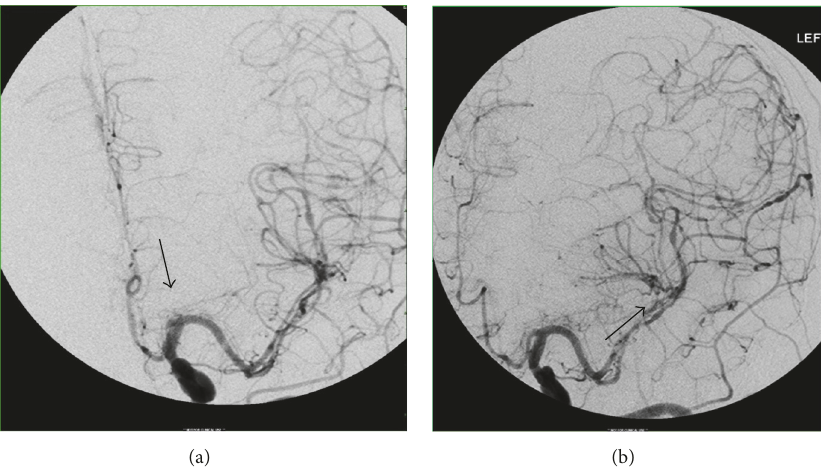
Figure 1: Conventional cerebral angiography revealed (a) M1 segments of the middle cerebral artery and (b) M2 segments of the middle cerebral artery with classic beading pattern of constrictions indicative of cerebral vasculitis (black arrows).